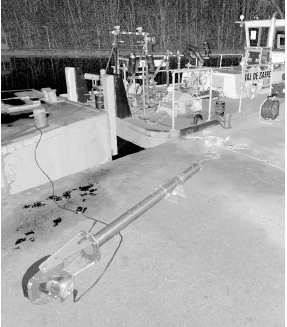
Figure 4. Intensity image taken while scanning the sonar and its supporting mast (in the foreground). The imaging system can be seen in the background.